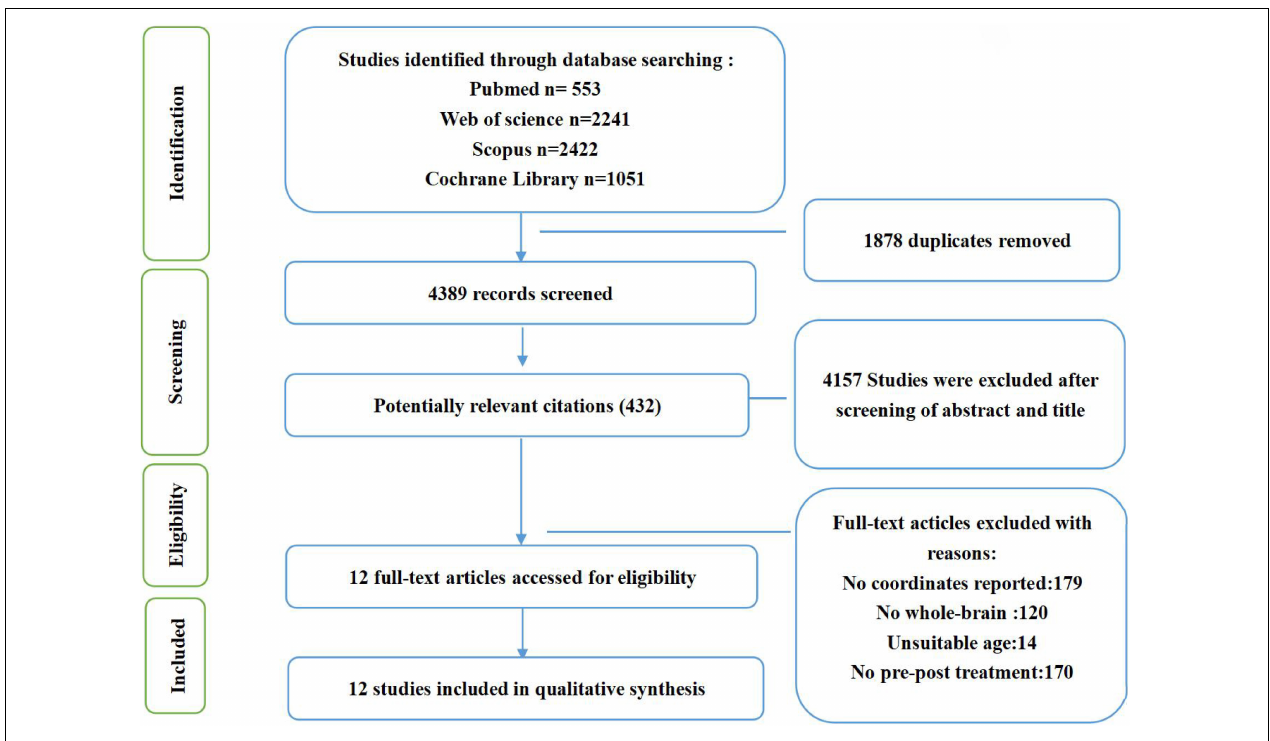
FIGURE 1 | Flowchart of the searching strategy and study selection process, based on PRISMA template (Liberati et al., 2009; Moher et al.,